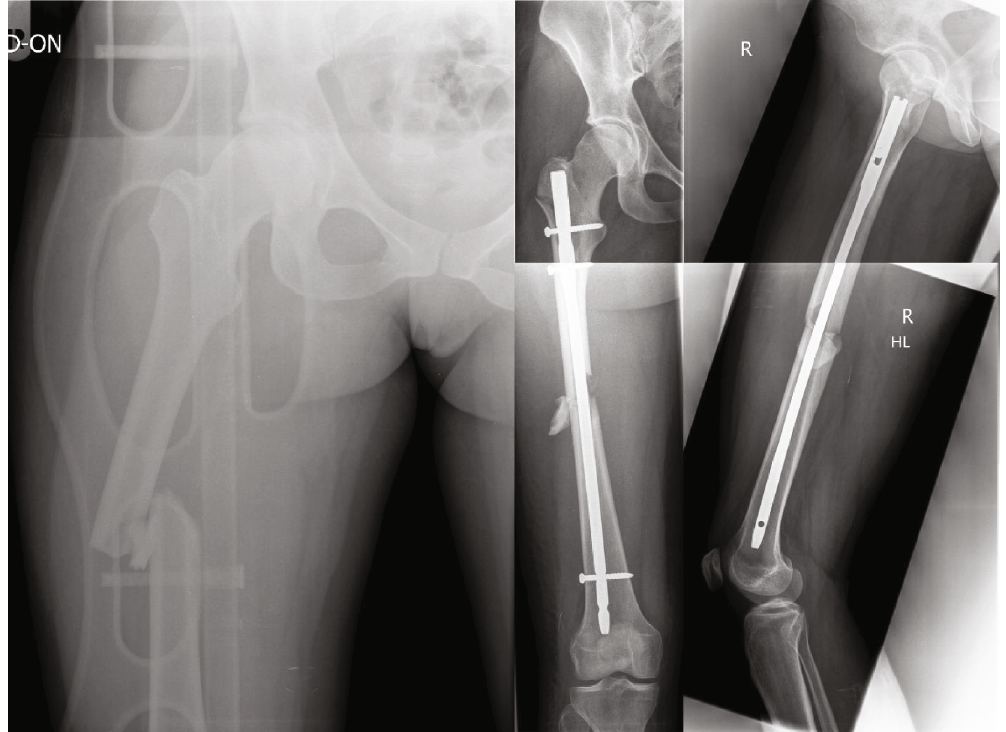
Figure 2: Patient B, a 28-year-old female patient with right-sided midshaft femoral fracture before and after surgery.